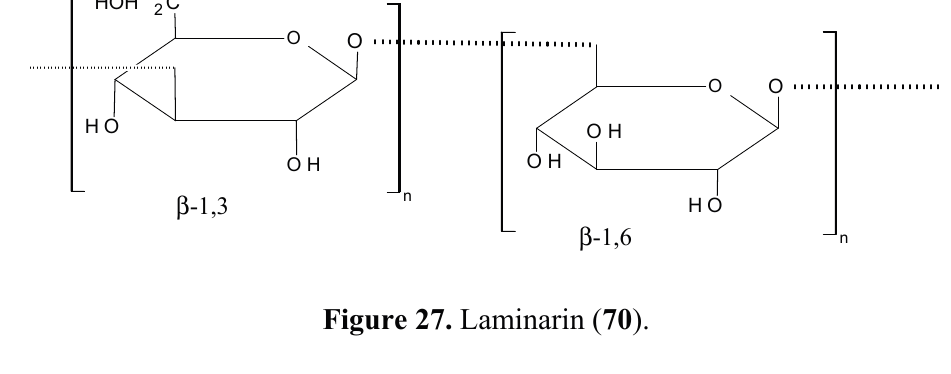
Figure 27. Laminarin ( 70